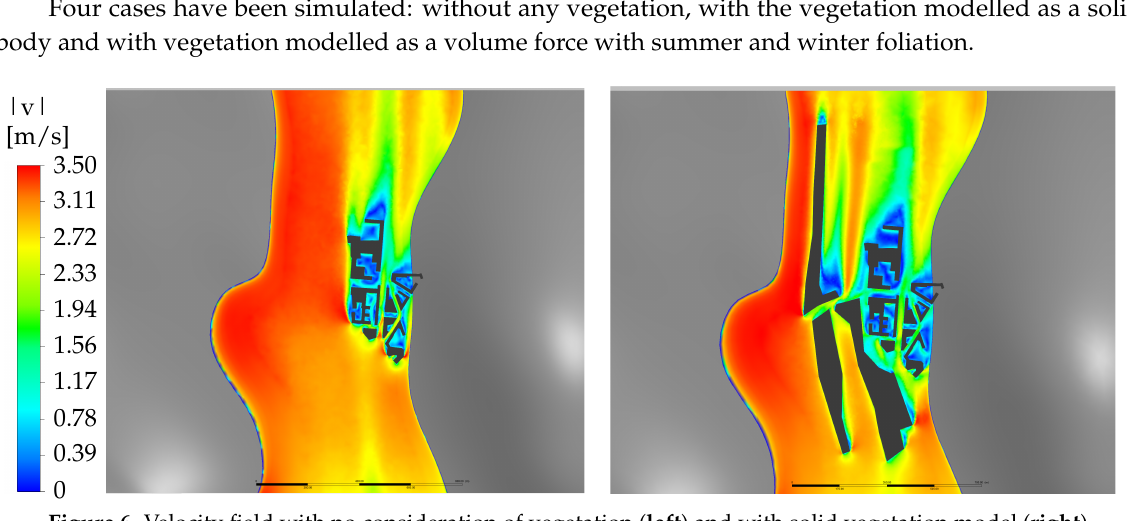
Figure 6. Velocity field with no consideration of vegetation ( left ) and with solid vegetation model ( right ). The additional three solids model the